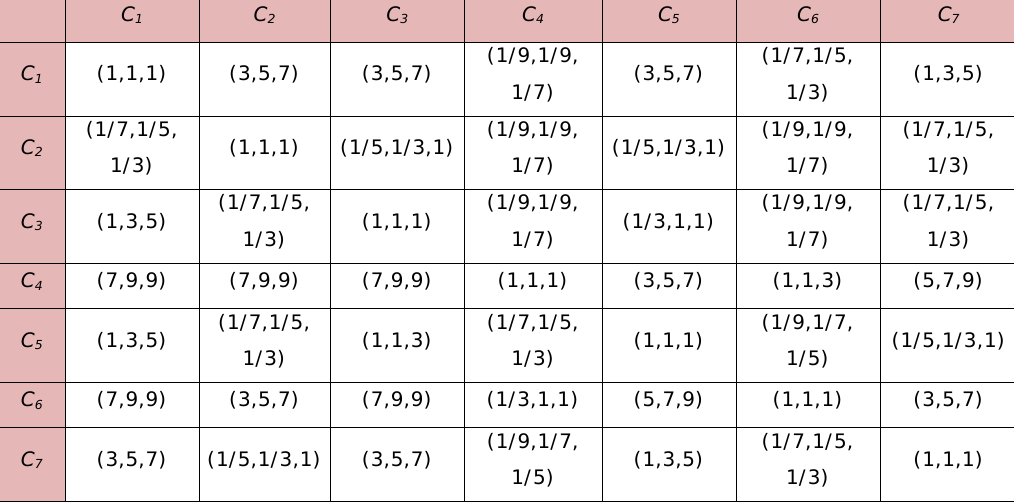
Table 2. “Fuzzy comparison matrix of criteria with respect to the overall